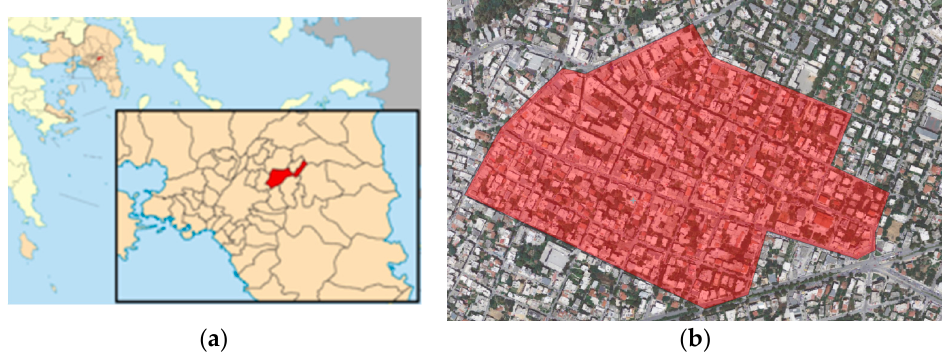
Figure 21. Case study area—a part of Chalandri municipality. (a) Chalandri municipality in Attika region. (b) Case study area